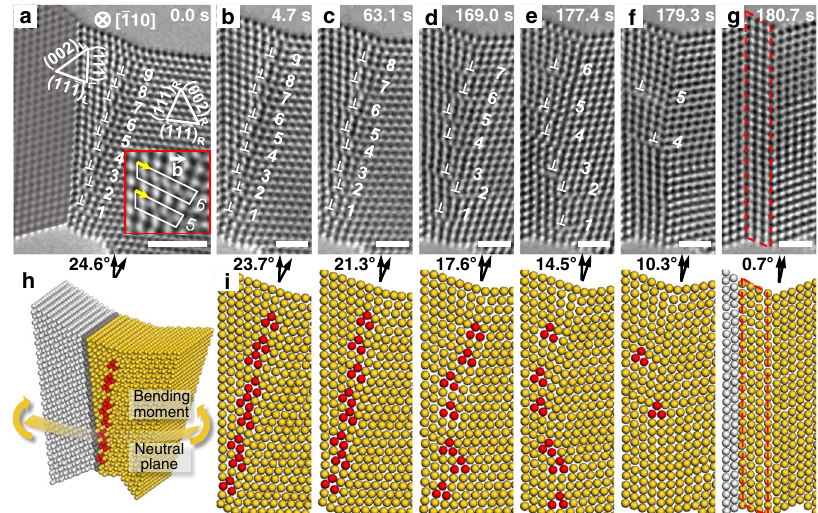
Fig. 1 Representative in situ HRTEM images showing room-temperature dislocation climb at an HAGB and atomic models reconstructed from the HRTEM images. a – g Dislocations are marked by both symbols ⊥ and numbers. Burgers circuits in the inset of a indicate the identical edge components of the dislocations. The newly formed twin lamella is denoted by red dashed lines in g . Scale bar: a 2 nm and b – g 1 nm. h Atomic model reconstructed from the HRTEM image in a . The pre-existing Σ 3 TB is marked by a dark grey plane and the dislocation cores are highlighted by red atomic columns. The yellow curved plane indicates the neutral plane of bending. i Reconstructed atomic con fi gurations corresponding to the HRTEM images in b – g